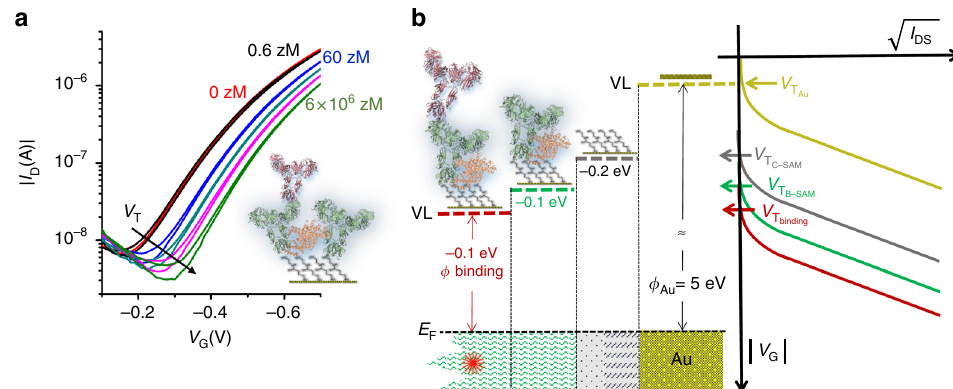
Fig. 2 Sensing measurements. a The SiMoT transfer characteristics ( I D vs. V G at V D = − 0.4 V). The red curve corresponds to the anti-Human-IgG SAM incubated in the bare PBS solution. The same gate is further exposed, in sequence, to PBS standard solutions of IgG at concentrations of 6 zM (black curve), (6 ± 3) × 10 zM (blue curve), (6 ± 1) × 10 2 zM (dark curve), (6.7 ± 0.1) × 10 3 zM (magenta curve) and (6.67 ± 0.01) × 10 6 zM (light green curve). The decrease of the gate work-function ( ϕ ) at the different functionalization steps and after the IgG binding is schematically depicted in ( b ) and correlated to the measured V T shifts towards more negative gate voltages. E F is the gate electrochemical potential while VL is the vacuum level. The V G axis is directed towards negative values and the measured I D values